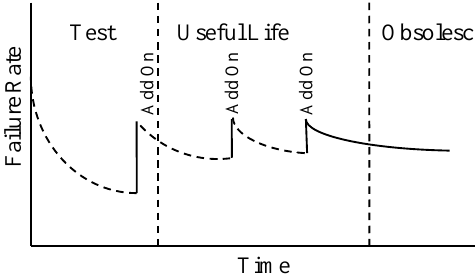
Fig.1. Failure rate curve due to feature enhancements for software